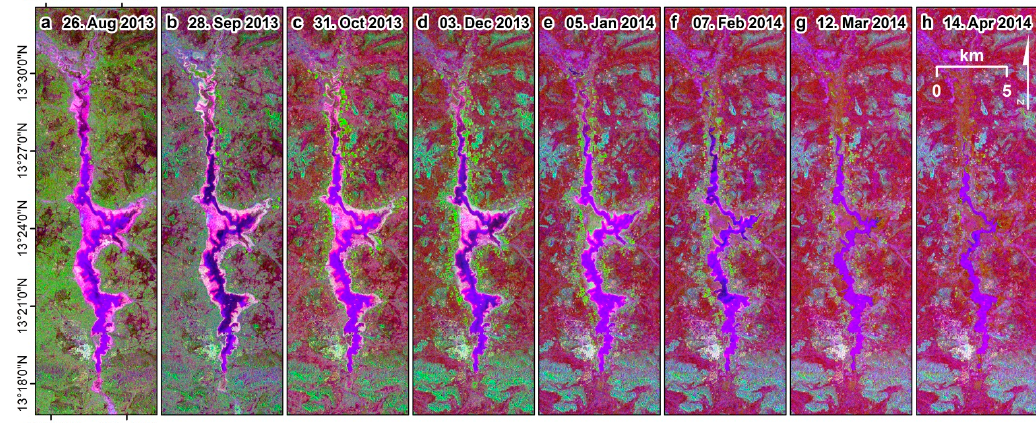
Figure 8. Time series of eight selected HH-VV polarized TerraSAR-X (TSX) StripMap acquisitions from ( a ) 26 August 2013; ( b ) 28 September 2013; ( c ) 31 October 2013; ( d ) 3 December 2013; as well as ( e ) 5 January 2014; ( f ) 7 February 2014; ( g ) 12 March 2014; and ( h ) 14 April 2014 (©DLR 2013–2015). False color composites have been created from the Kennaugh elements (K 4 -K 0 -K 3 ). Open water appears in blue/purple, green colors stand for vegetated or irrigated areas, and pink colors are dominant in areas of flooded vegetation.